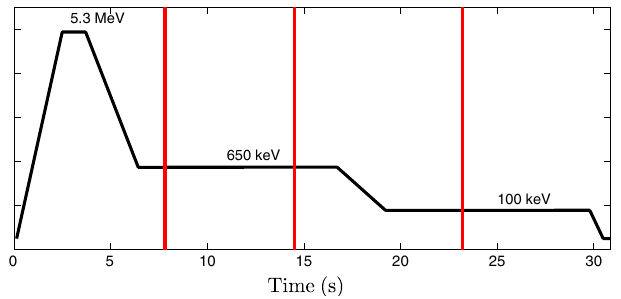
FIG. 1. Cycle times at which sets of scraper measurements were performed, marked with vertical red